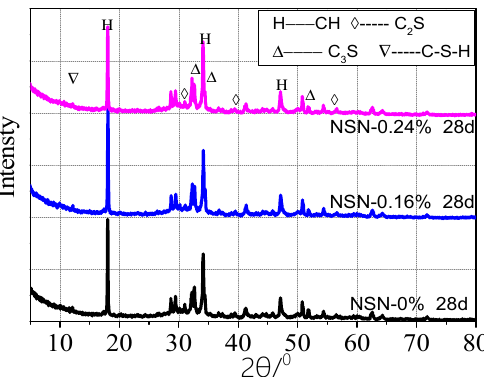
Figure 7. Hydration products of cement-based material with different contents of NSN.